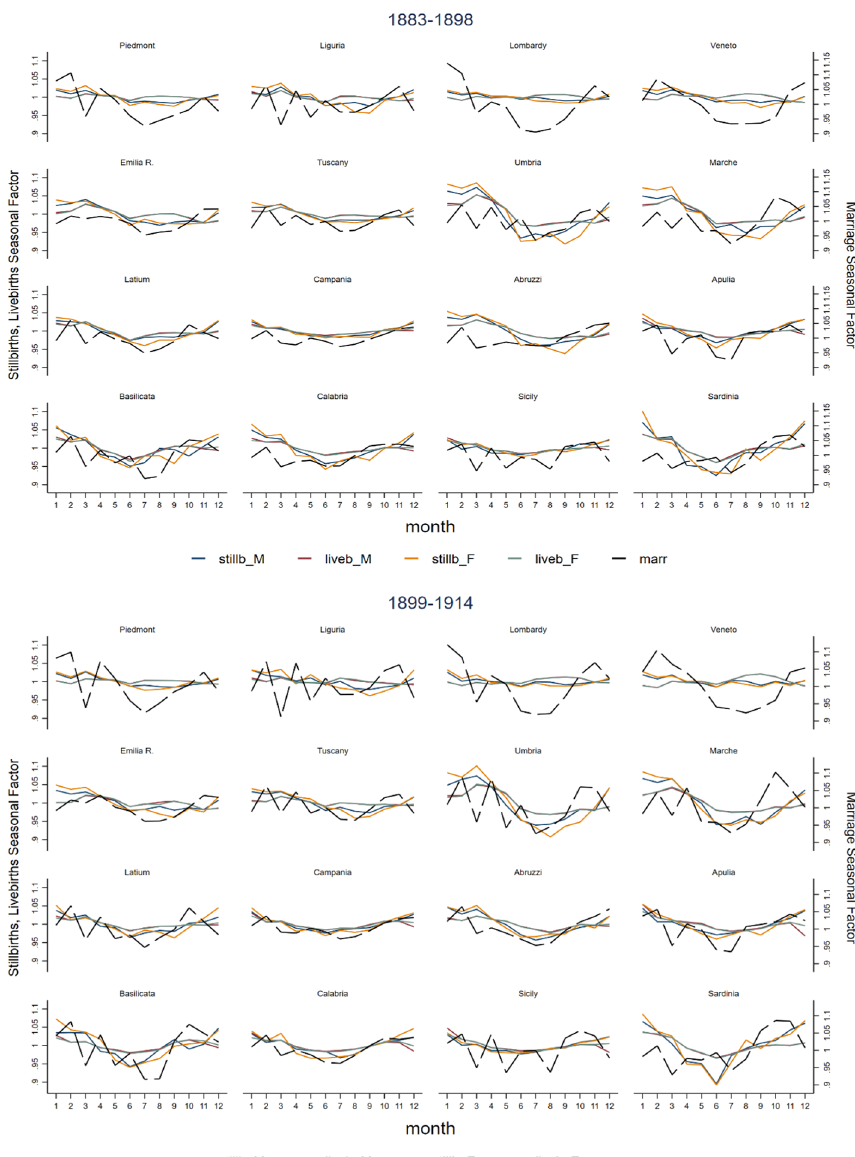
Fig. 2 Seasonal pattern of live births, stillbirths and marriages in the Italian regions,